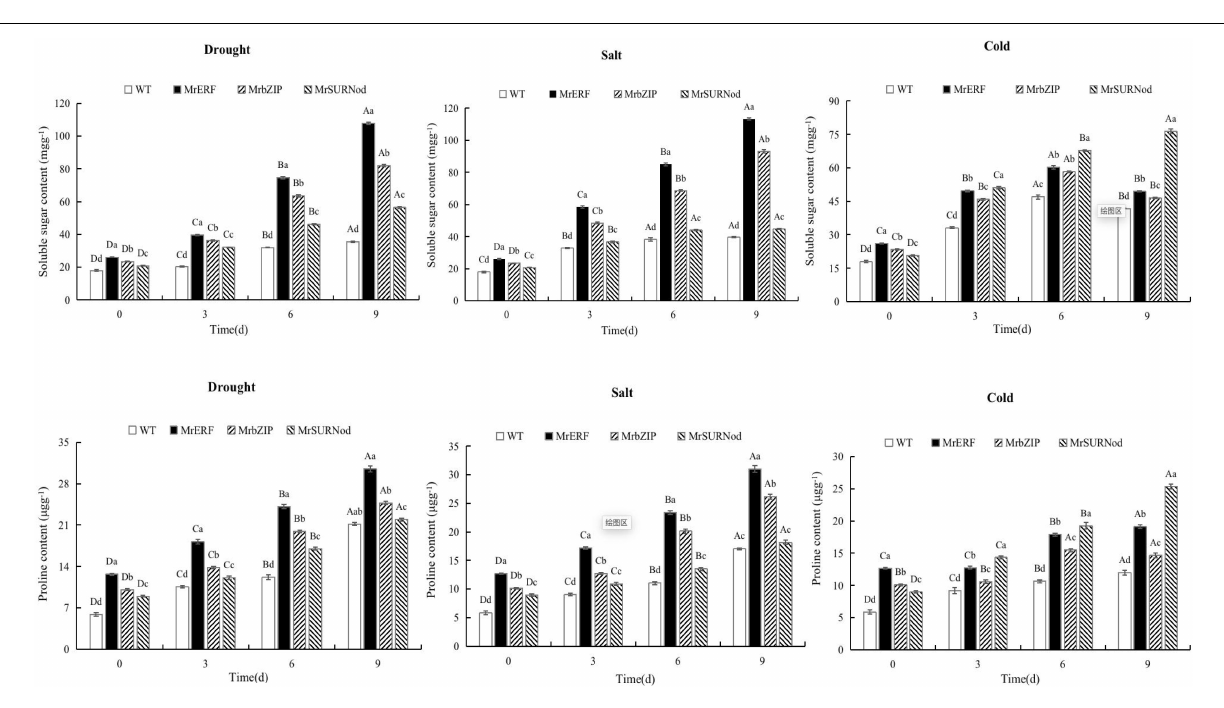
of other transcription factors related to plant stress resistance, such as OsERF65 (Zhao et al., 2021) and VrbZIP52 (Wang